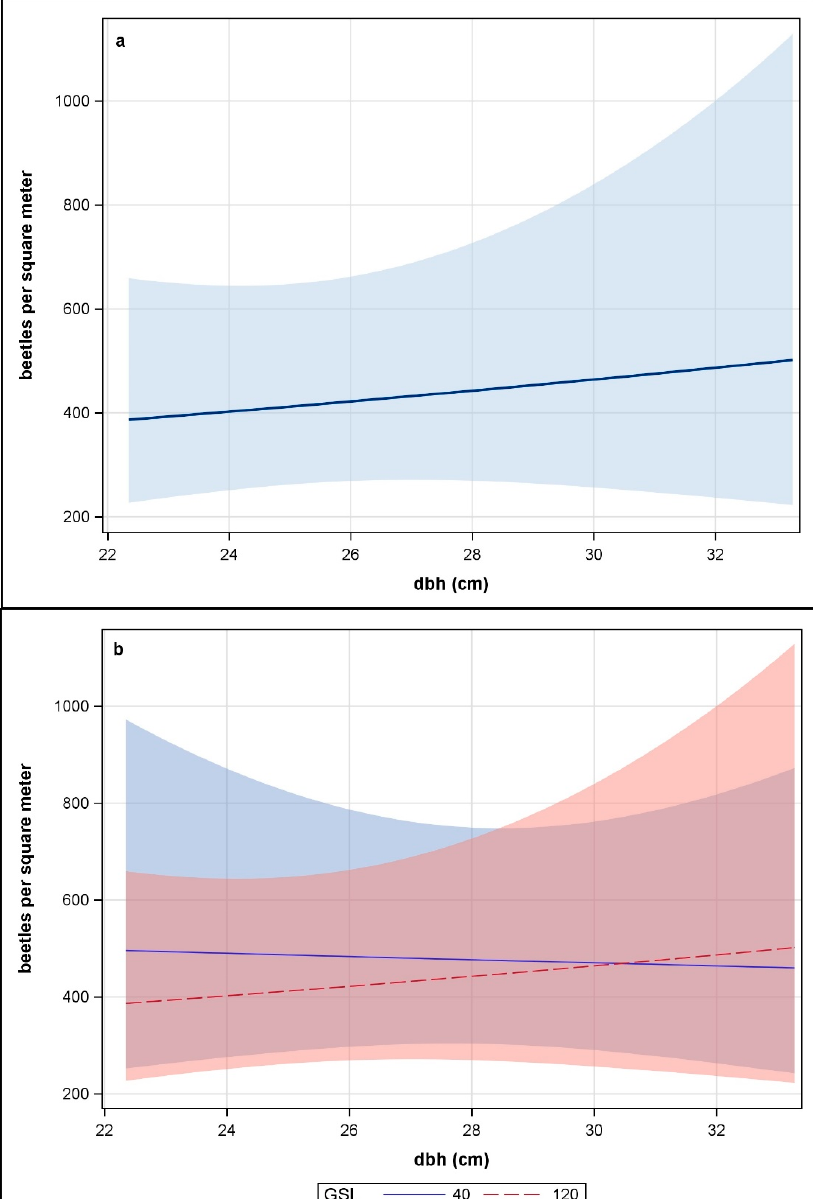
Figure 1. Relationship between number of Dendroctonus ponderosae beetles emerging per square meter from Pinus contorta and tree diameter at breast height (dbh in cm) ( a ) across growing stock levels 40 and 120, color band denotes 95% confidence interval, n = 80; and ( b ) and per GSL, color bands denote 95% confidence intervals, n = 40 for each GSL, Fraser Experimental Forest and Colorado State Forest, CO, 2007–2008.